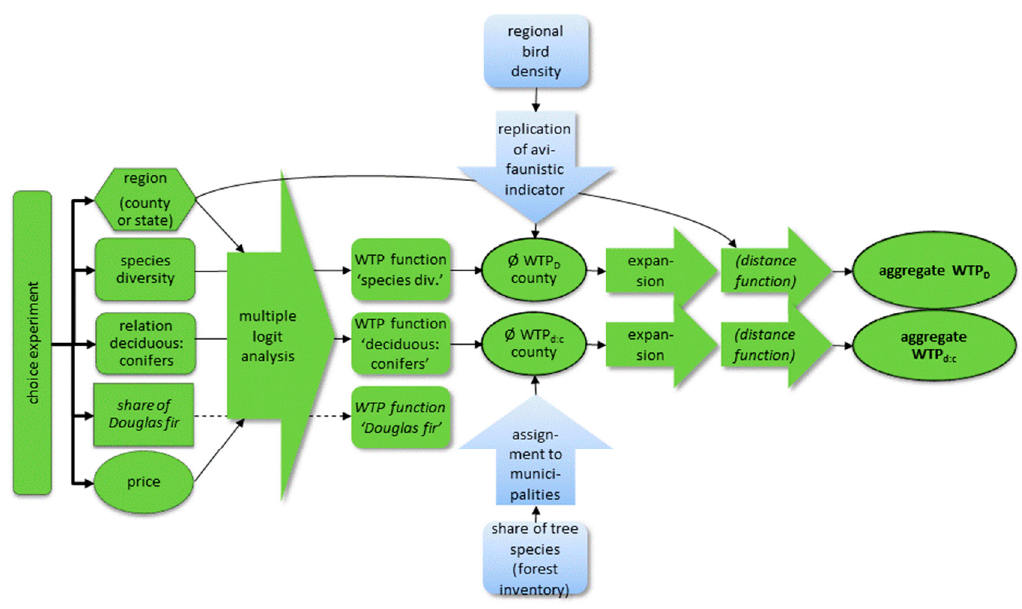
Figure 4. Procedure for quantifying and valuing nature and landscape ( italics: not applied